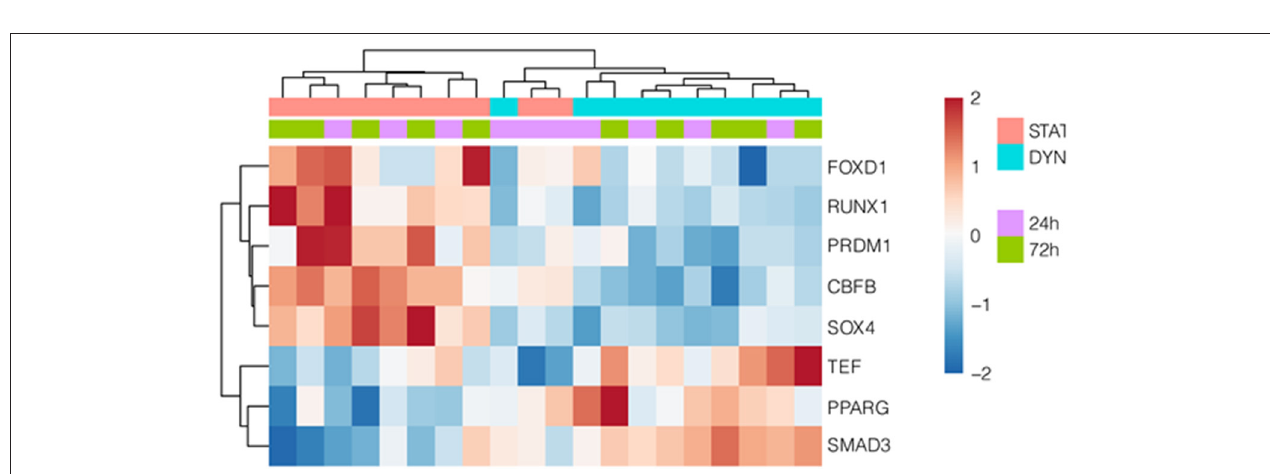
FIGURE 4 | Transcription factors potentially regulating AMIGO2. Hierarchically clustered heatmap showing differentially expressed TFs, that are predicted to regulate AMIGO2. The motif-based TF prediction was performed using iRegulon on the complete set of DEGs at both time